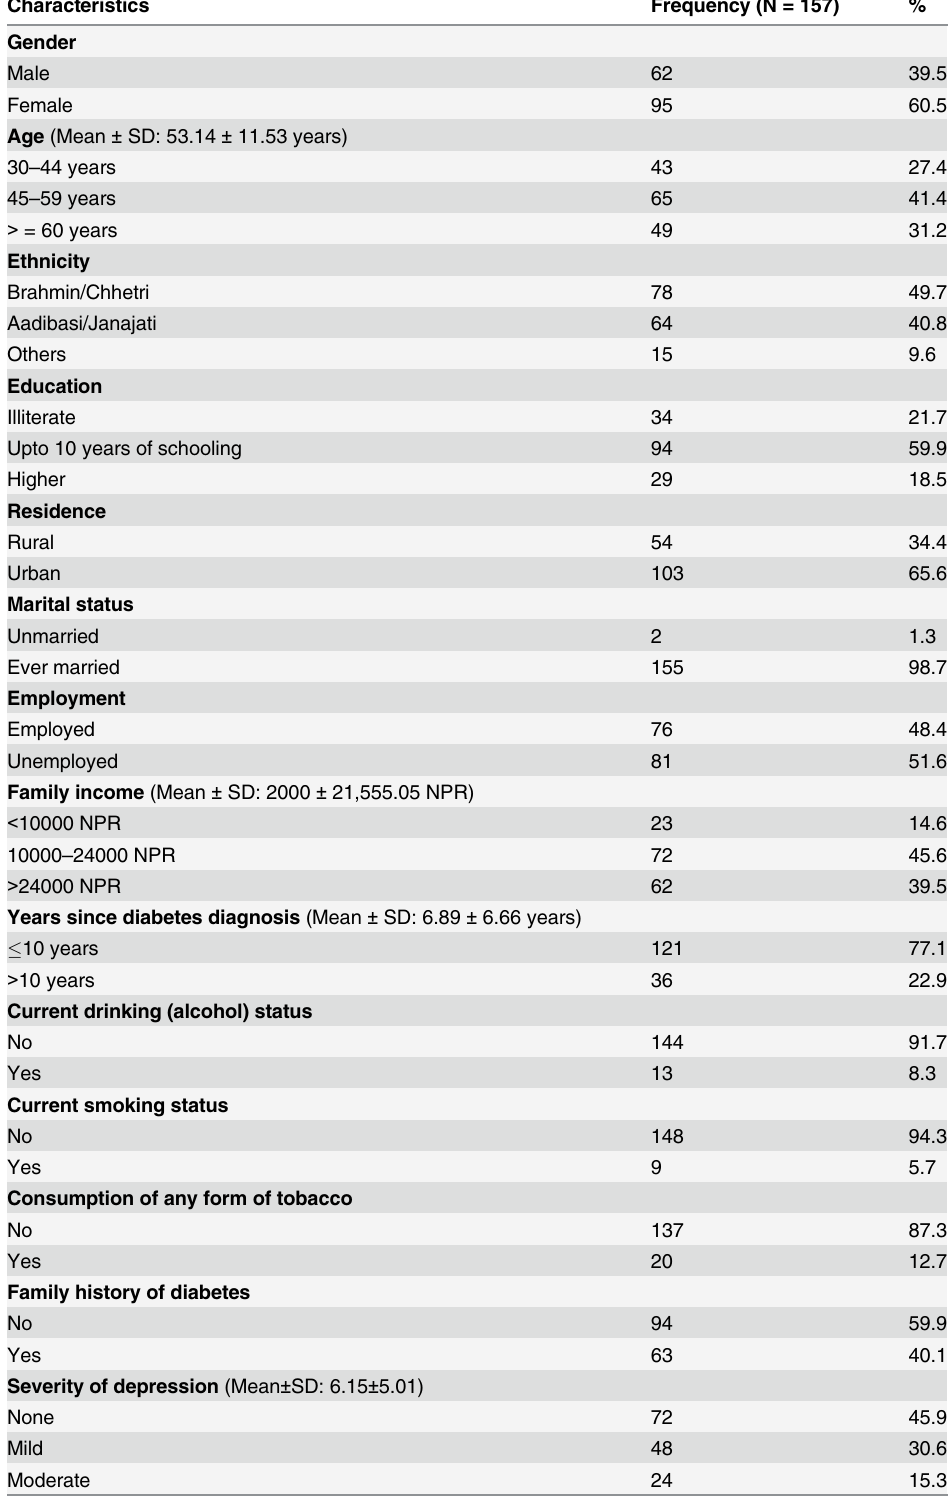
Table 3. Demographic characteristics of the study